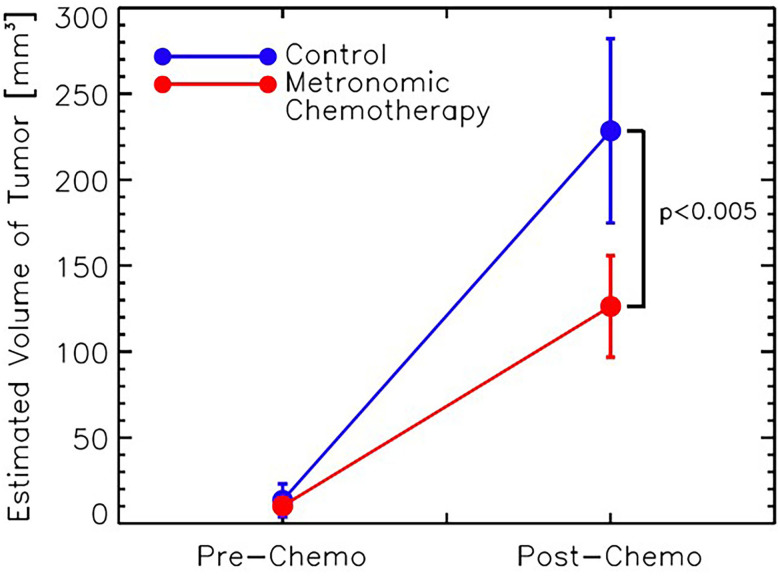
Estimated tumor volume sizes compared between control (blue line) and metronomic chemotherapy-treated mice (red) at day 7 and day 17.A significant decrease in volume size was noted in the MCT mice (p < 0.005).